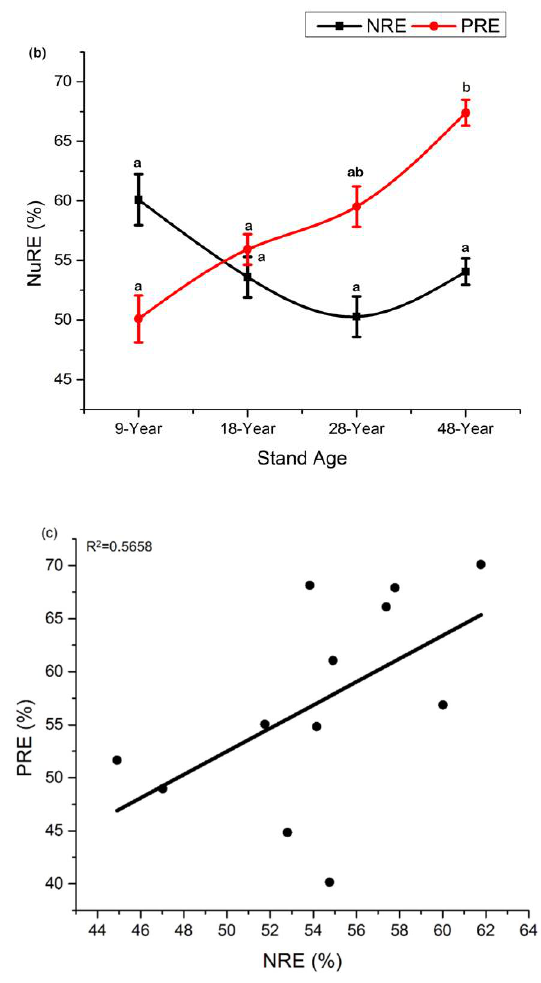
Figure 6. Changes in ( a ) NRE (nitrogen resorption efficiency), ( b ) NRE: PRE and ( c ) PRE in stand ages, and the relationship among NRE and PRE ( d ) among P. massoniana plantation chronosequence. Lines represent the average value with three replicates ( n = 3 ), whereas the lower-case letters (a,b) represent the trend among stand age ( p < 0.05). Error bars represent standard error.